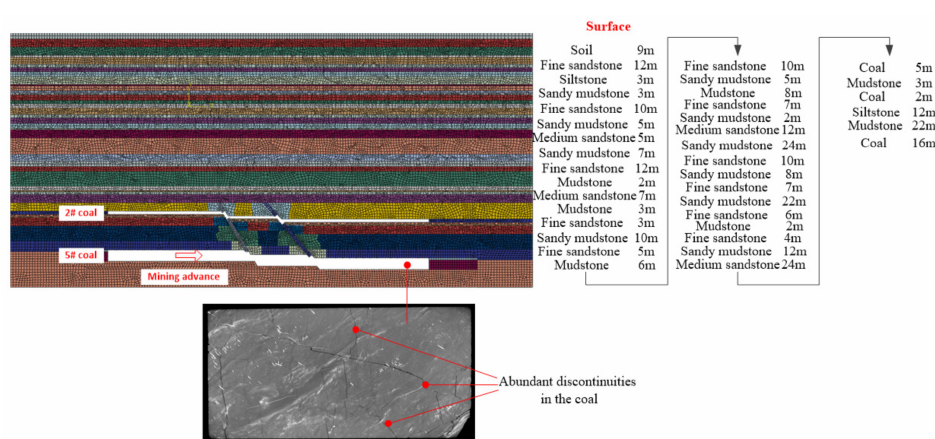
Figure 5. Numerical calculation model and CT results of coal